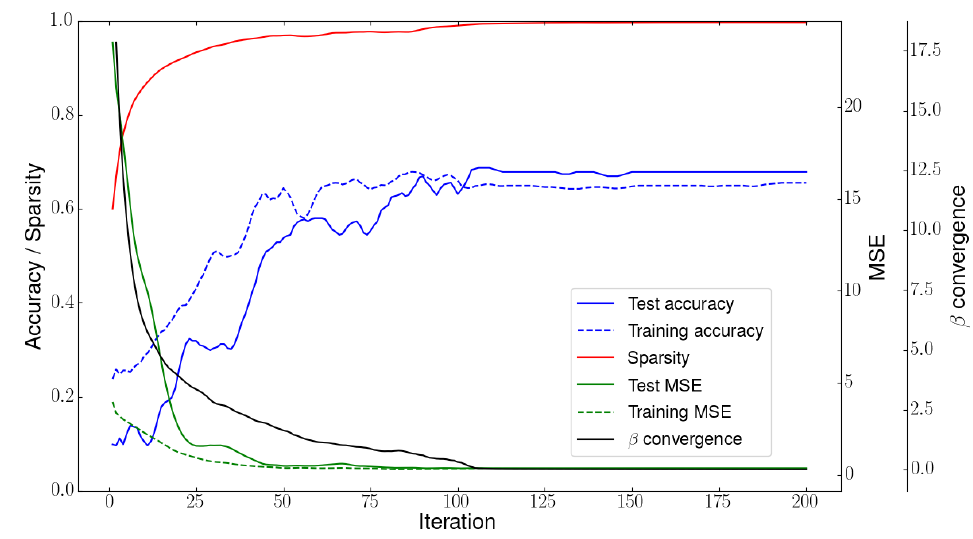
Figure 5. The learning curve obtained from training the model with the optimal hyperparameters. From the model coefficients β , the importance of each point p can be derived by the norm of its corresponding coordinates’ model coefficients: (cid:107) β p (cid:107) 2 . Figure 4 visualizes the vertices importance values of the final model coefficients on different views of the femur.